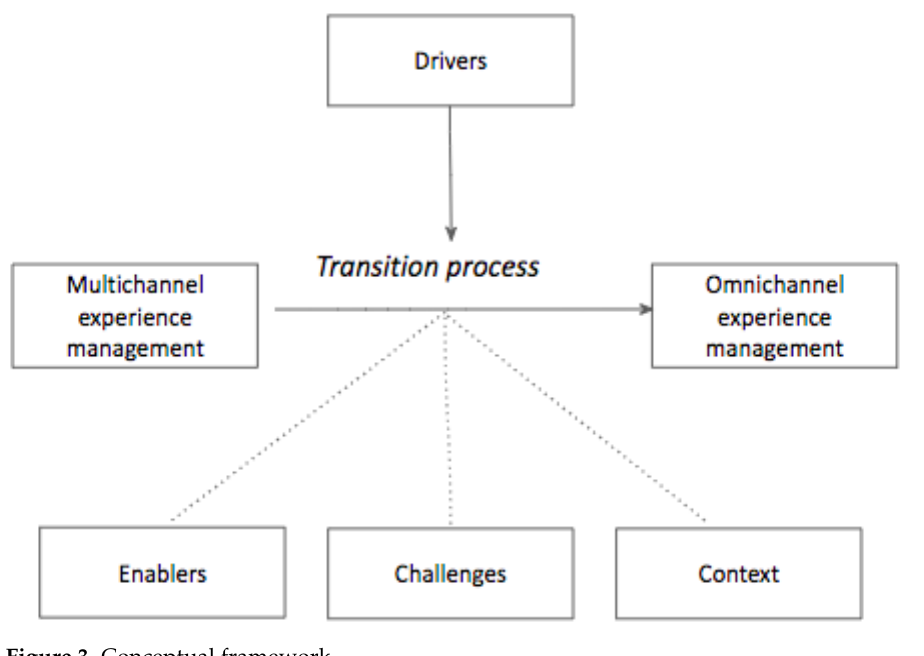
Figure 3. Conceptual framework. Table 1. Summary of the